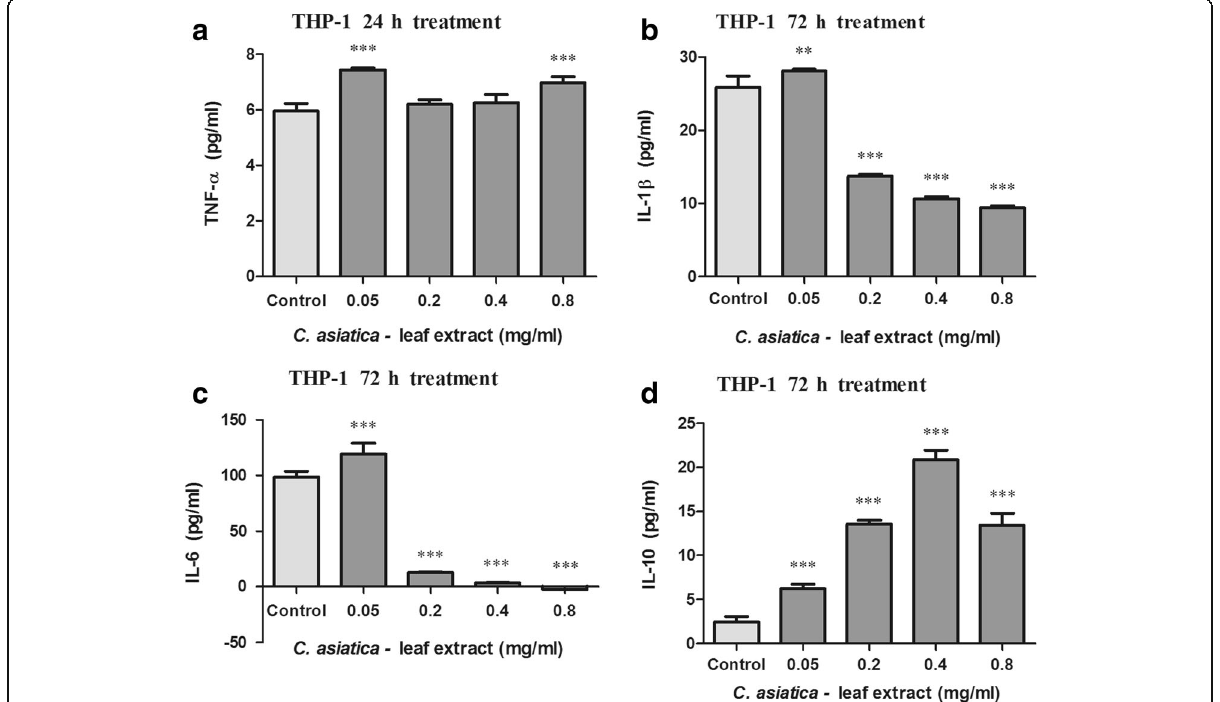
Fig. 4 Concentration of TNF- α ( a ), IL-1 β ( b ), IL-6 ( c ) and IL-10 ( d ) in C LE treated THP-1 cells (Values expressed as mean ± SD, ** p < 0.001, *** p < 0.0001 compared to the control)